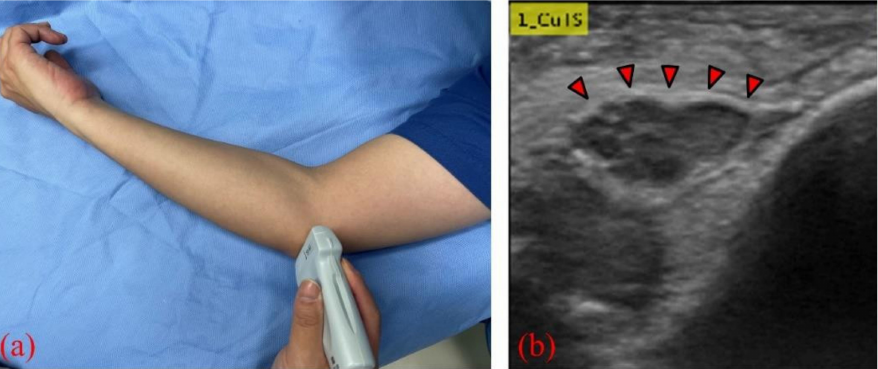
Figure 1. ( a ) US probe placed on the medial epicondyle to visualize the ulnar nerve; ( b ) short-axis image of the ulnar nerve (red arrows) at the level of the medial